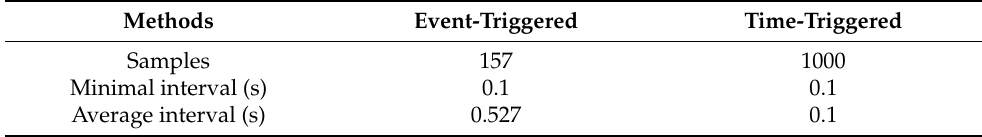
Table 2. Comparison of Nonlinear System